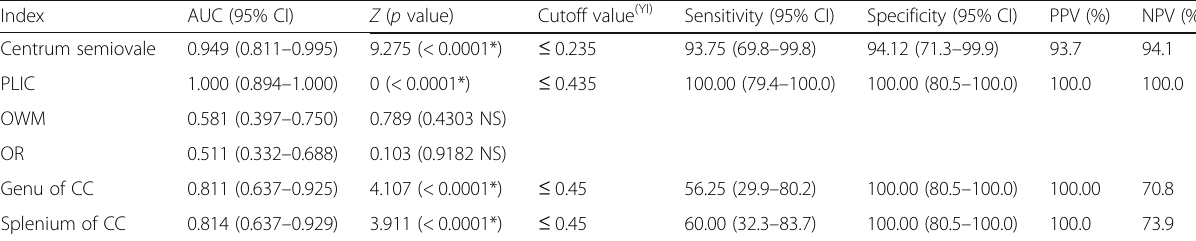
Table 4 ROC curve analysis of DTI/FA values for discrimination of occurrence of cerebral palsy